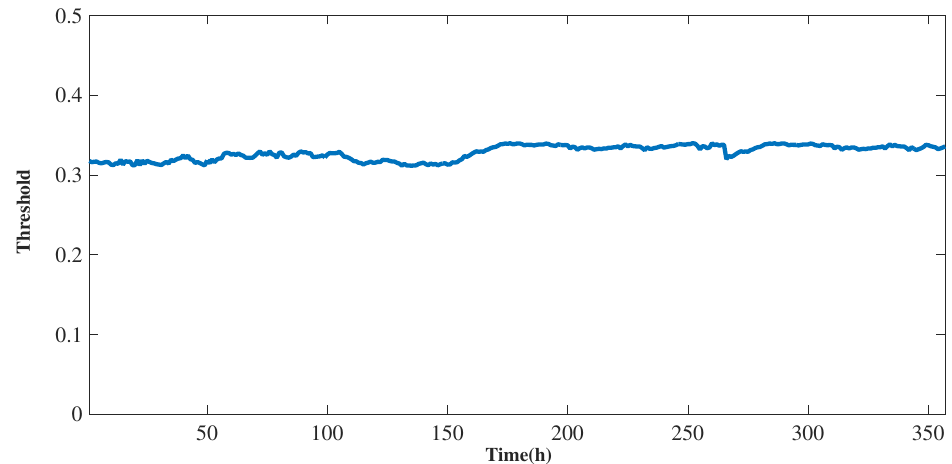
Figure 6. Threshold of online